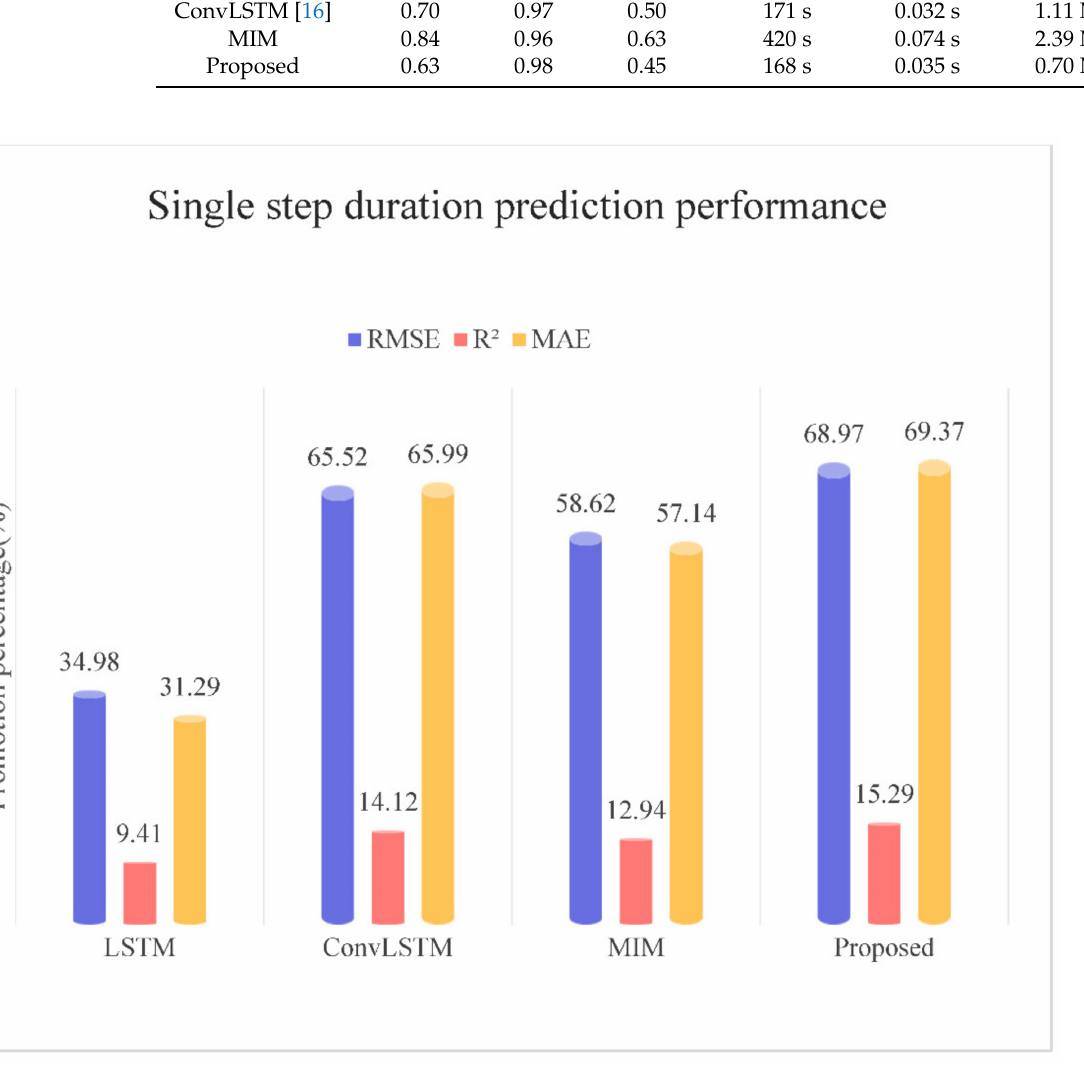
Figure 10. Single-step duration prediction